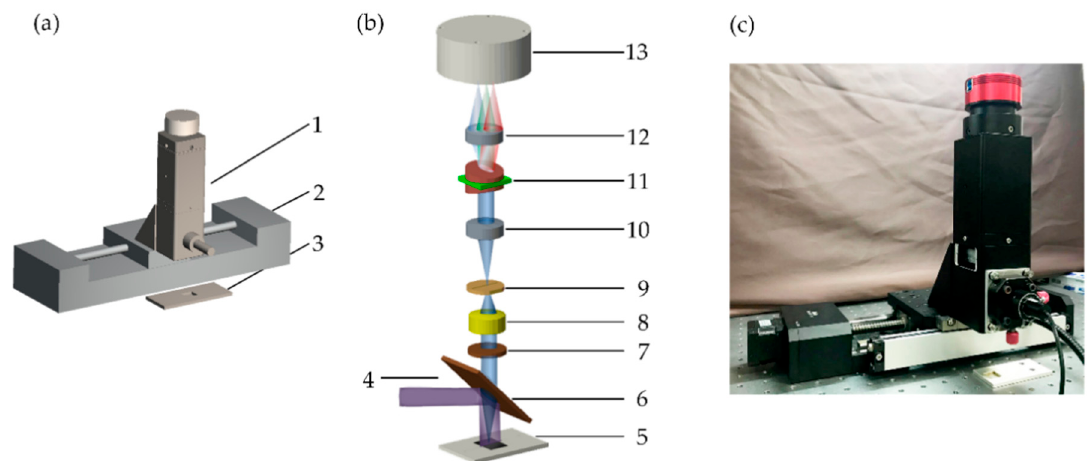
Figure 1. ( a ) Schematic of the fluorescent hyperspectral detection system. 1, Imaging spectrometer; 2, motorized linear stage; 3, sample slot. ( b ) Optical path of the hyperspectral detection system. 4, Line laser; 5, sample slot; 6, dichroic beam splitter; 7, longpass filter; 8, lens; 9, slit; 10, aspherical achromatic lens; 11, prism-grating-prism pair; 12, aspherical achromatic lens; 13, area-array complementary metal-oxide-semiconductor (CMOS) camera. ( c ) A photo of our hyperspectral detection system.